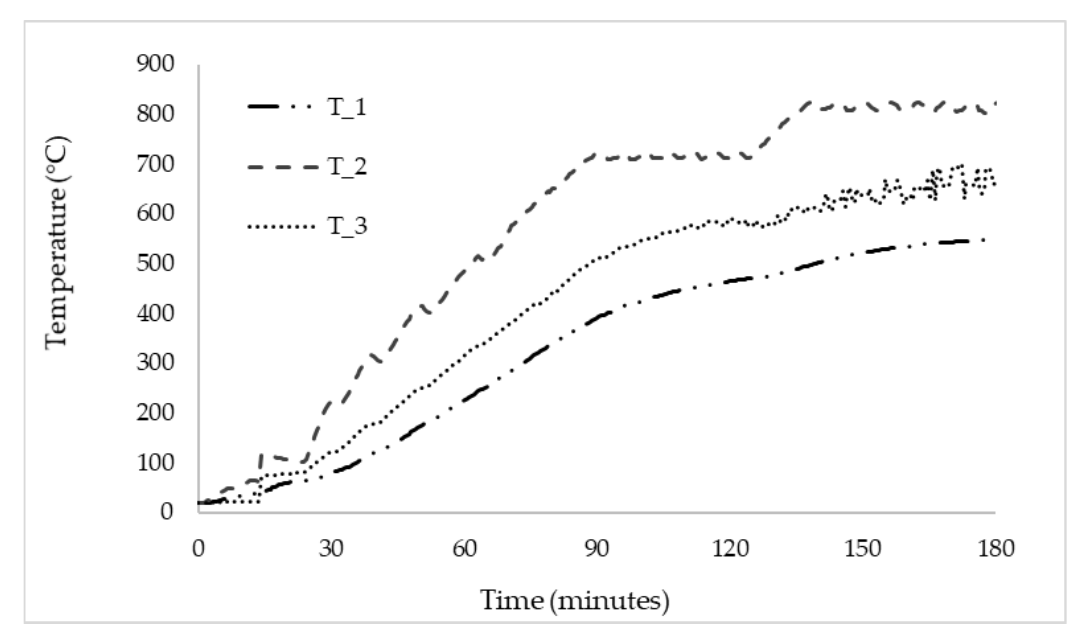
Figure 9. Steel plate test results.